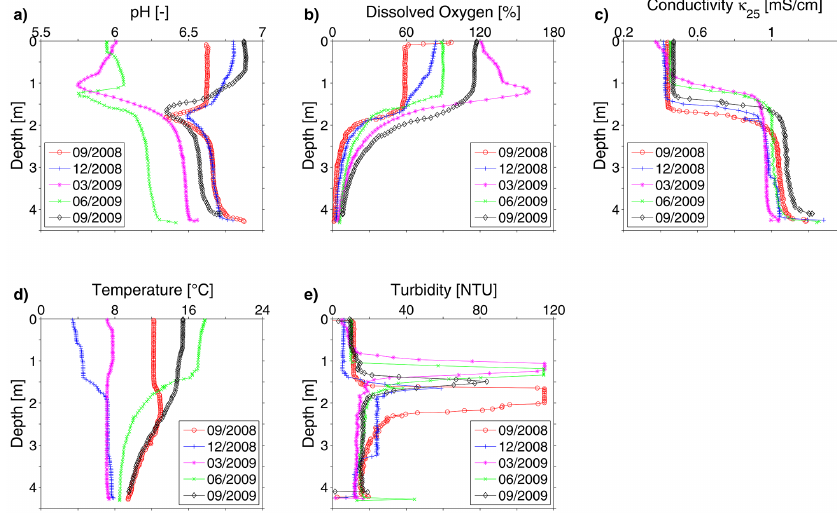
Figure 2. Physico-chemical profiles in Waldsee between September 2008 and September